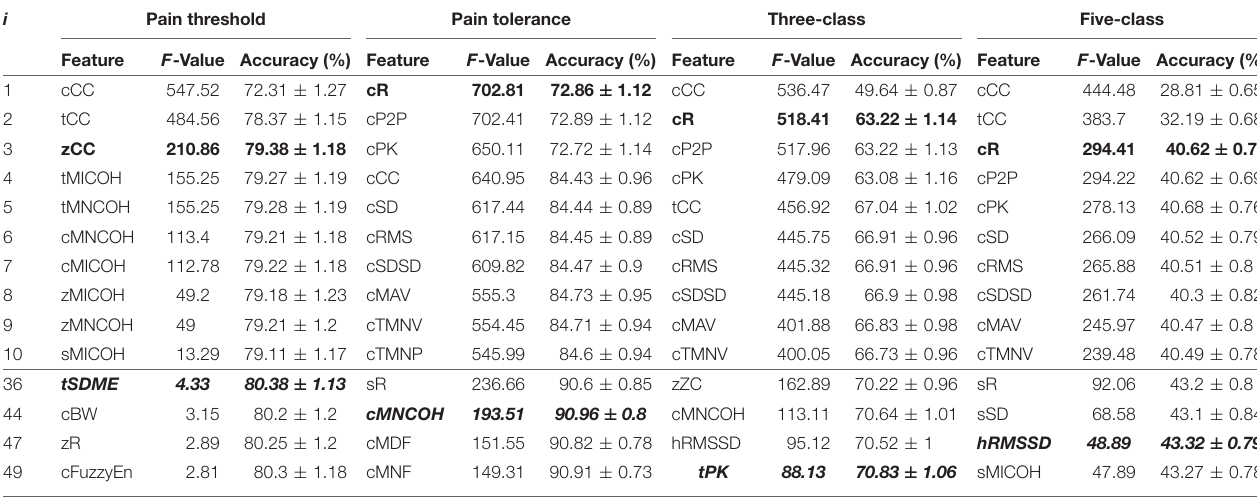
i denotes the rank of feature’s F-value and SFS iteration included in the model. Feature abbreviation, and the classification accuracy (mean ± sd) were displayed for each of the four classification problems. Local maxima are indicated by bolded entries in the upper part of table. Iterations were abridged within the lower part of table where global maxima for each classification task are indicated by bold